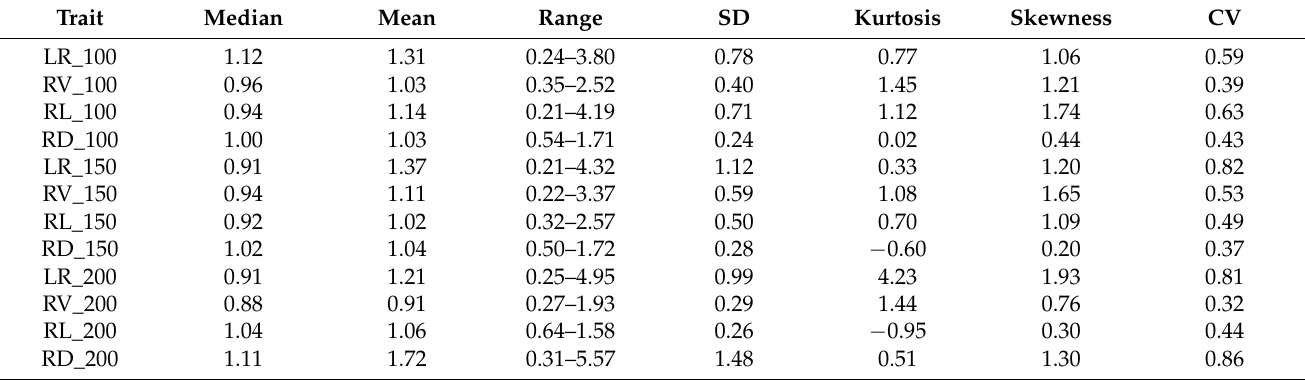
Table 1. Phenotypic variation for 4 root traits under 3 different salt concentrations, including